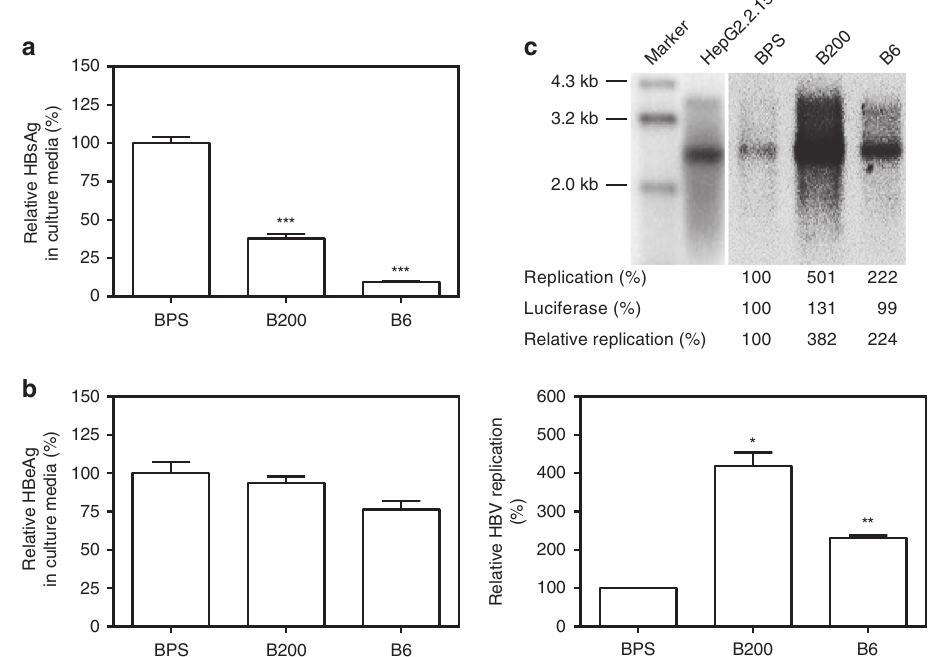
Fig. 2 Comparison of viral expression and replication of BPS, B6 and B200 in vitro. HBV HDI plasmids were transfected into Huh-7 cells and culture supernatants at 48 h post transfection were assayed for HBsAg ( a ) and HBeAg ( b ) by ELISA. Intracellular capsid-associated HBV DNA was analysed in Southern blot ( c , top panel), and quanti fi ed using densitometry scanning ( c , bottom panel). HepG2.2.15 was analysed in parallel as signal position control. Transfection ef fi ciency was normalised by measuring luciferase expressed from co-transfected pGL3 plasmid and data were normalised taking BPS measurements as 1. Transfections were performed in triplicates and repeated twice independently. Means and s.e.m. of the two repeats are plotted. c (top) shows representative Southern blot results. Statistical signi fi cance was calculated using unpaired two-tailed t -test ( a , b , c , bottom panel). * p < 0.05; ** p < 0.01; *** p < BPS persistence correlates with failed immune response . Next, mouse responses to BPS vs. B6 and B200 were compared to identify host processes and factors affecting persistence vs.